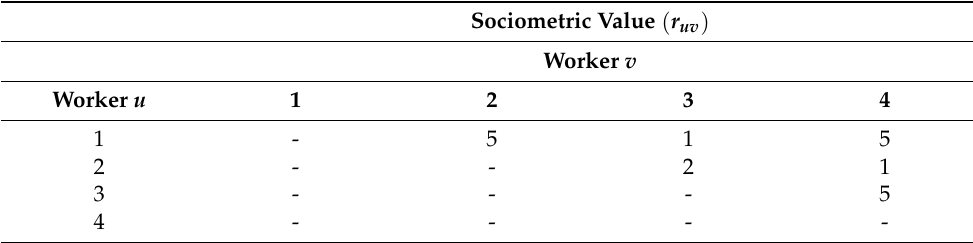
Table 4. Workforce sociometric value for the example